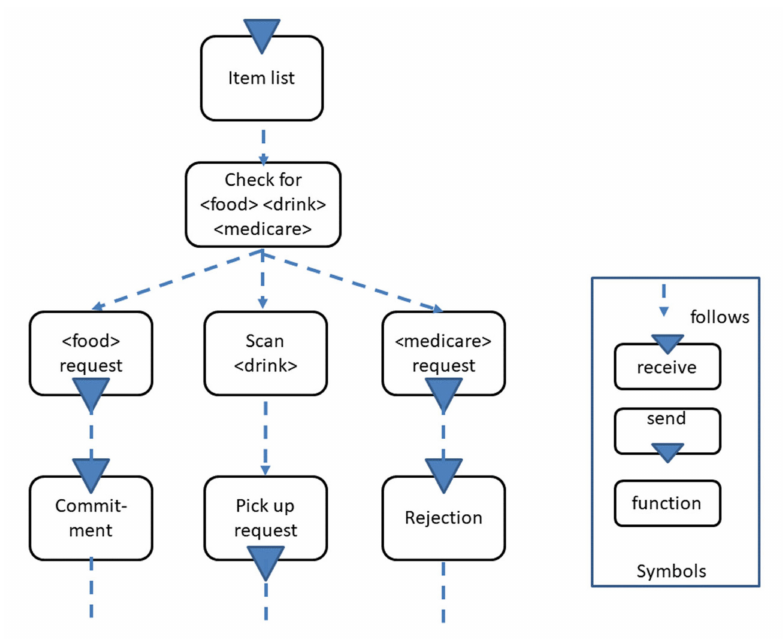
Figure 12. Exemplified decision-making behavior